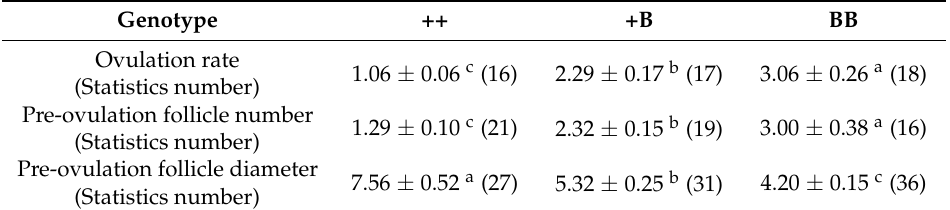
Table 1. Measurements of ovulation rate, number, and diameter for